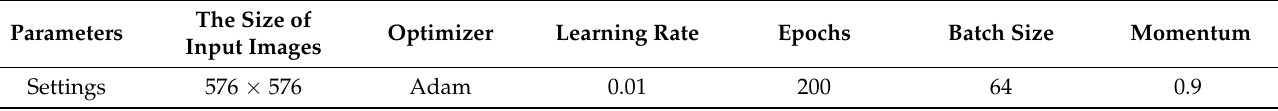
Table 3. Configuration of training parameter value for Ablation Experiments.